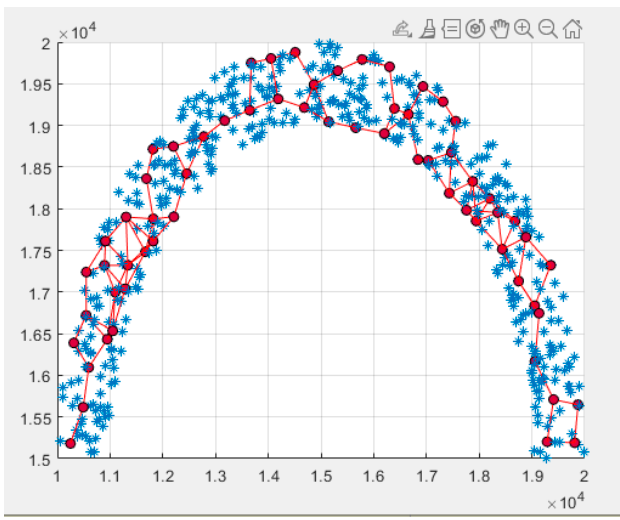
Figure 12. Detected skeleton for 10,000 m × 500 m swarm.